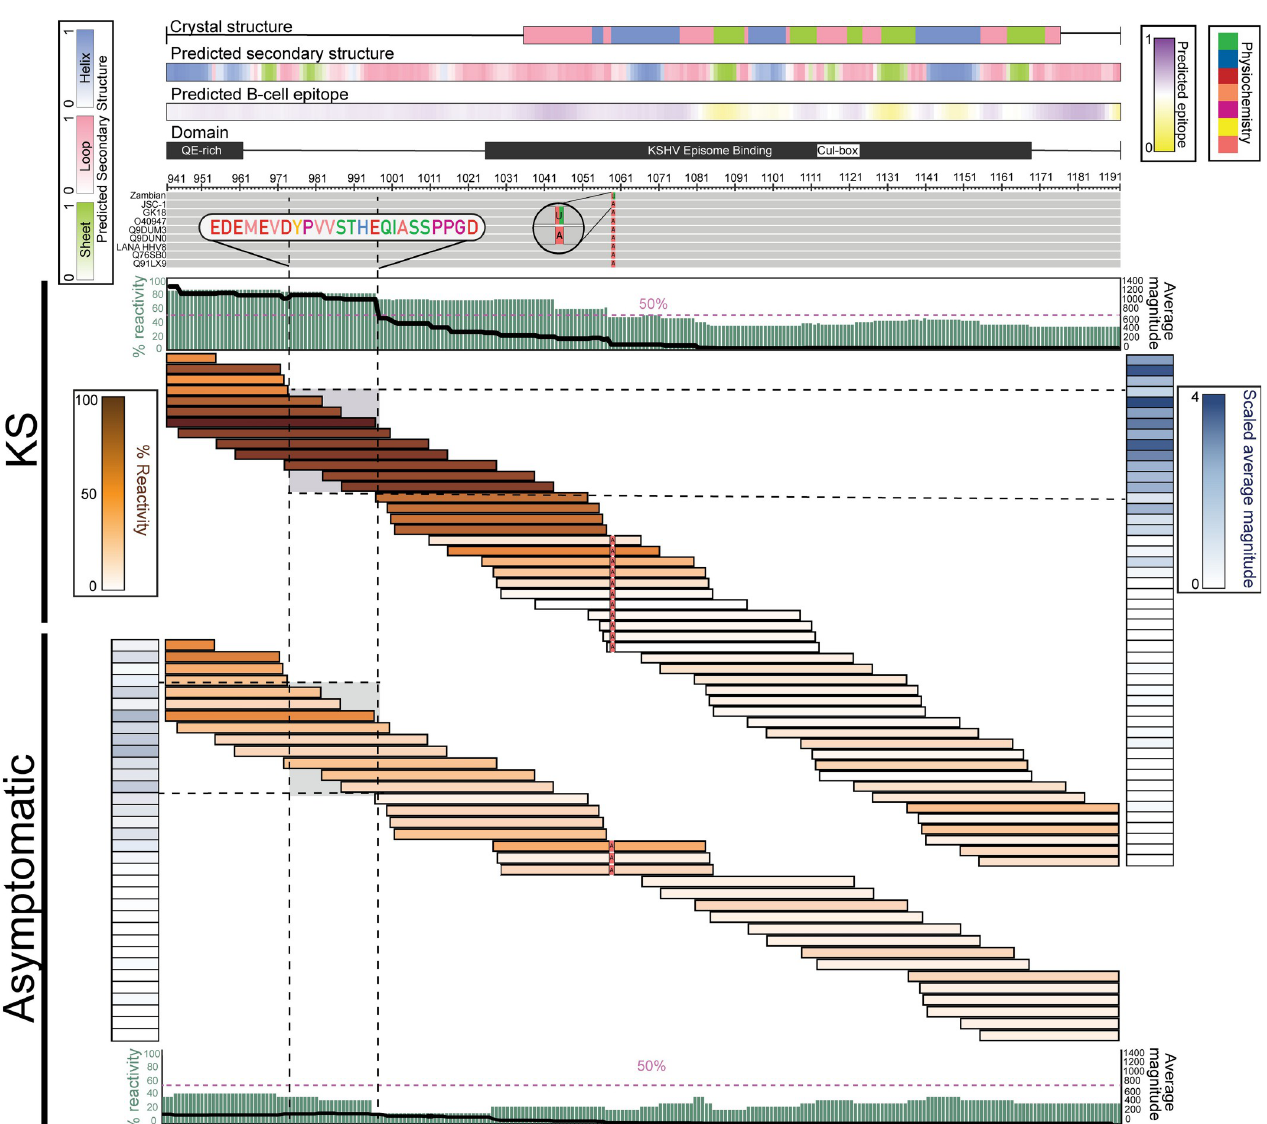
Fig 5. KSHV-LANA C-terminus epitope mapping in KS and asymptomatic individuals. The multiple sequence alignment (MSA) of reference sequences followed by the input library sequences is shown where gray represents conservation among the sequences. Mismatched residues are colored by their physiochemical properties as defined by the Zappo color scheme (green: hydrophilic, salmon: aliphatic/aromatic, orange: aromatic, fuchsia: conformationally special, yellow: cysteine only, red: negatively charged, blue: positively charged). Predicted secondary structures are represented in color gradients representing the probabilities (minimum [0; white] and maximum [1; sheet (green), loop (pink), or helix (blue)]). BepiPred-2.0 scores representing predicted B-cell epitope probabilities, along with functional motifs/domains are annotated directly above the aligned sequences. In addition, each peptide that was targeted by at least one individual was mapped and colored based on the percent cohort reactivity (brown gradient). Adjacent to the peptide responses of each group, scaled average magnitudes are shown in blue gradient. Moreover, percent patient reactivity and average magnitude of responses are calculated at the amino-acid level, represented by the sage bars and black lines in each group, respectively. LANA 974-997 is highlighted and the amino acid sequence is shown. QE-rich : Glutamine/ Glutamic acid-rich region , Cul-box : associated with Cullin-5